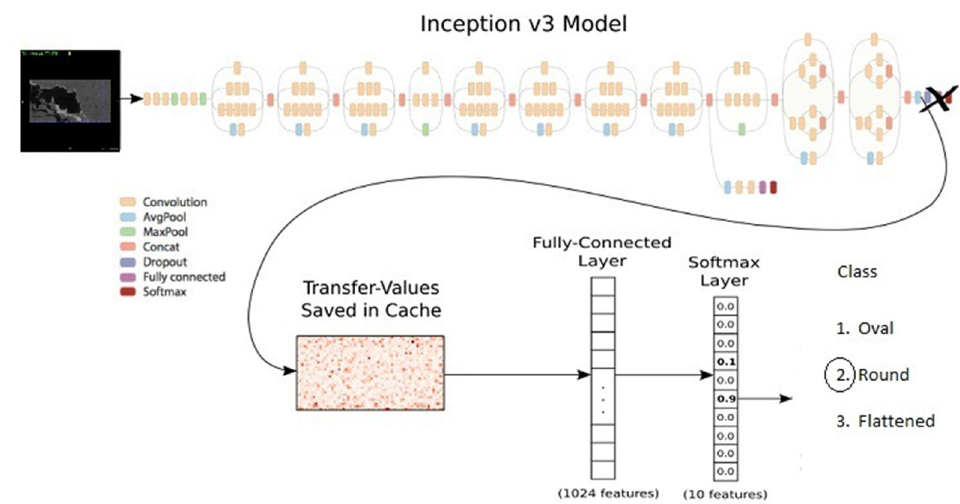
Figure 4. Deep CNN architecture of automatic sella classification.